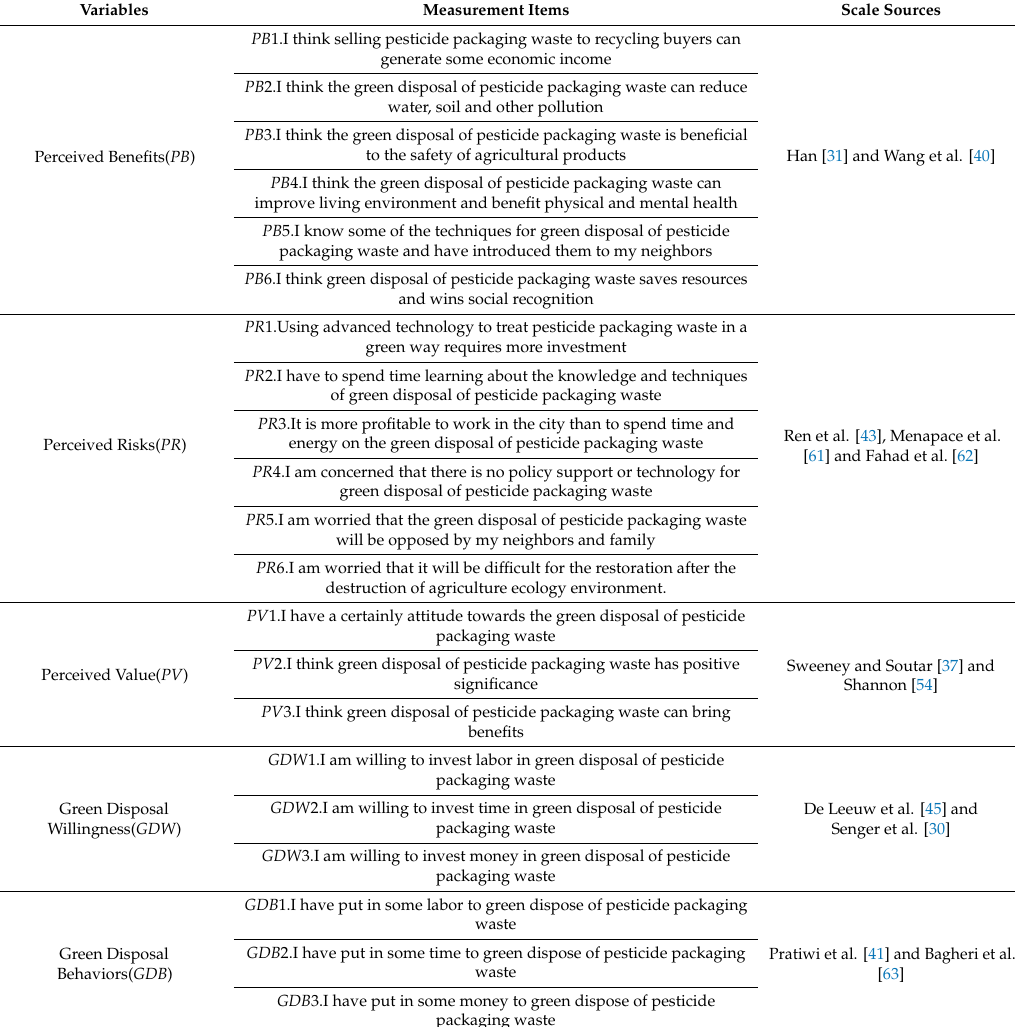
Table 1. Variables and measurement